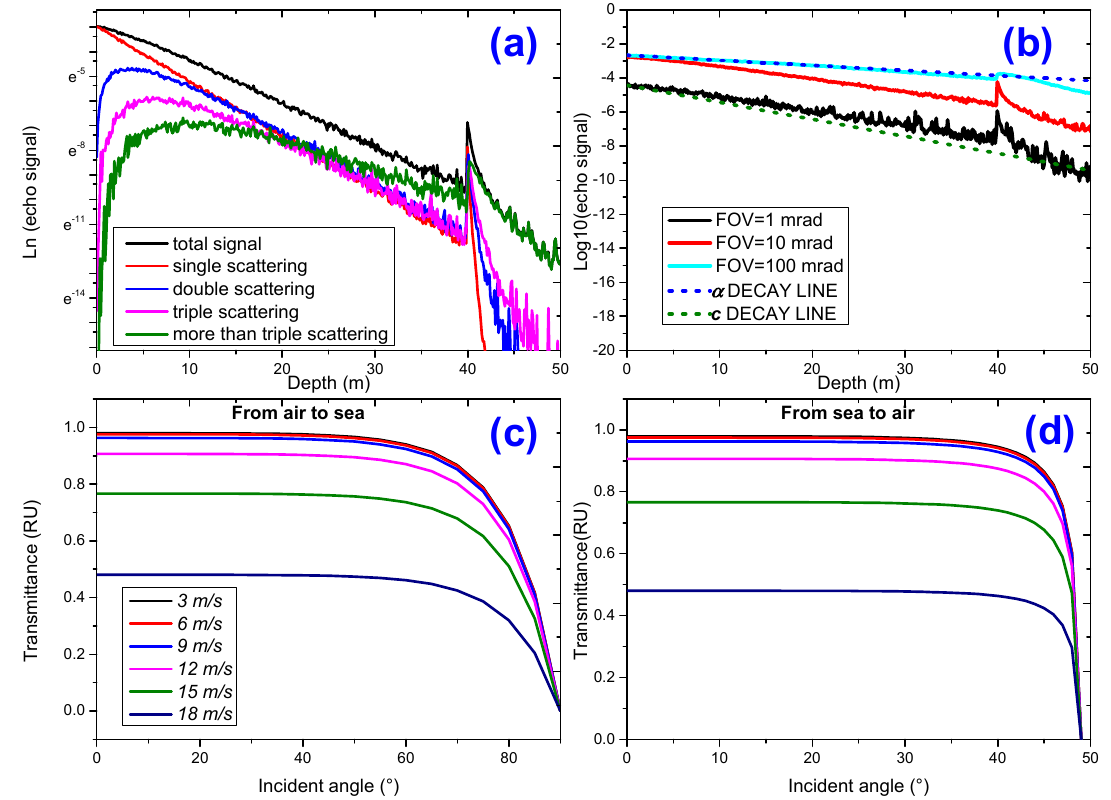
Figure 5. Wind-driven roughened sea surface and multiple scattering have significant effects on simulation results in logarithmic form: ( a ) Separation of contributions by different scattering order in the total signal, ( b ) field of view (FOV) influence on return signal, ( c ) influence of wind-driven roughened sea surface various incident angles on transmittance from air to sea, and ( d ) influence of wind-driven roughened sea surface various incident angles on transmittance from sea to air.